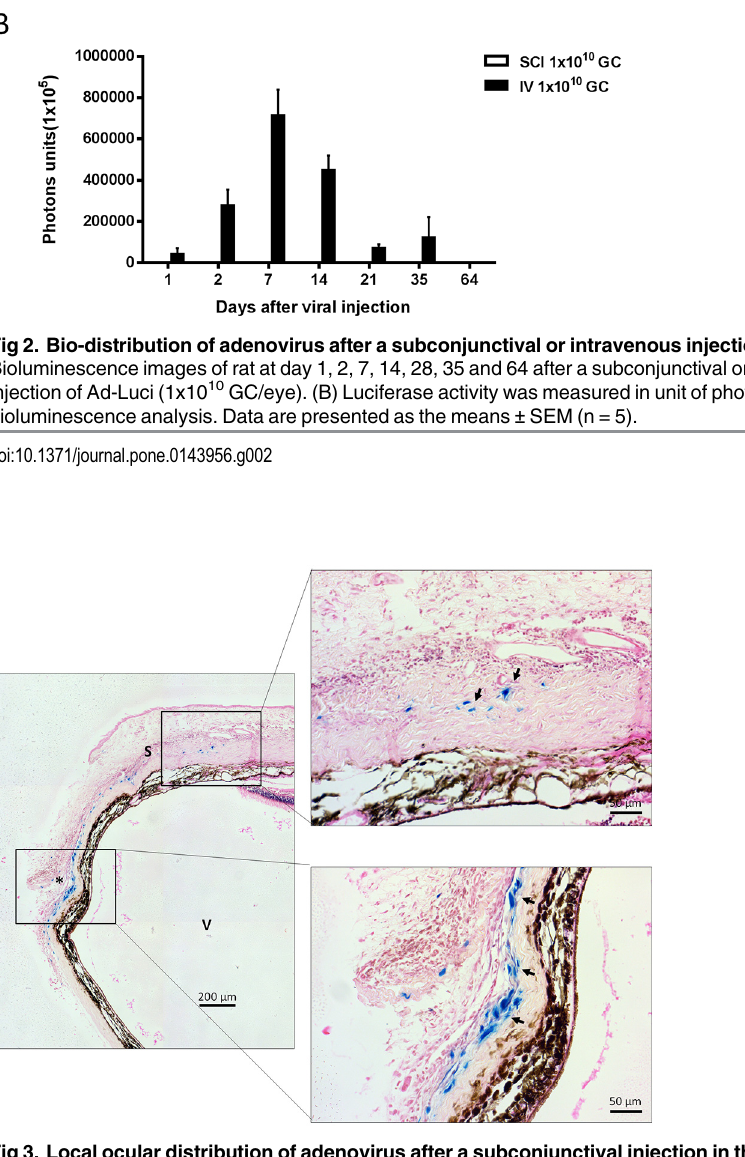
Fig 3. Local ocular distribution of adenovirus after a subconjunctival injection in the rats. Histological sections of the rat eyes injected with Ad-LacZ (1x10 10 GC/eye) in the subconjunctiva. The blue staining (arrows) in the image indicate the expression of β -galactosidase. V: vitreous; S: sclera. Scale bar = 200 μ m (left) and 50 μ m (right).